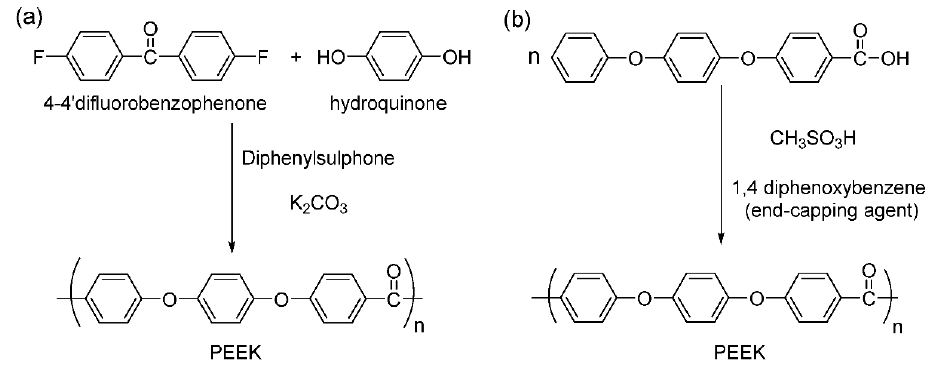
Figure 3. ( a ) Nucleophilic and ( b ) electrophilic poly(ether-ether-ketone) (PEEK) synthesis. Adapted Figure 3. ( a )Nucleophilicand( b )electrophilicpoly(ether-ether-ketone)(PEEK)synthesis.